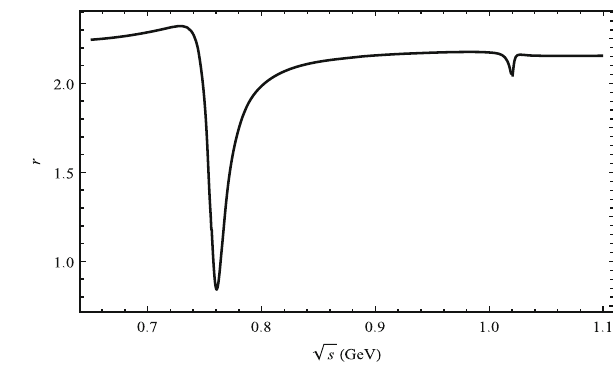
√ s corresponding to central param-